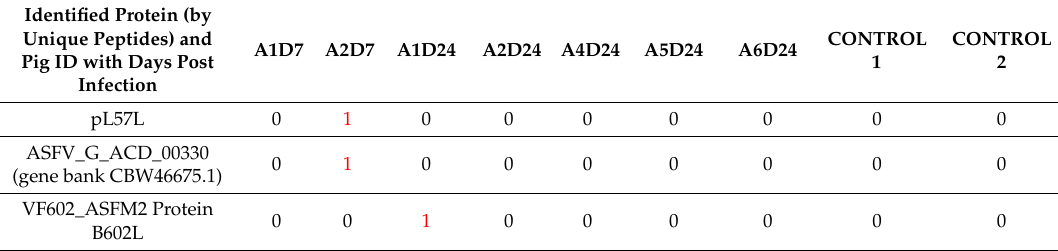
Table 1. Identified viral proteins in the OURT 88 / 3 group of porcine serum-derived EV-enriched fractions at 24 days post infection. Columns correspond to each animal at di ff erent time points (Group A, 7 and 24 dpi) where unique peptides were identified